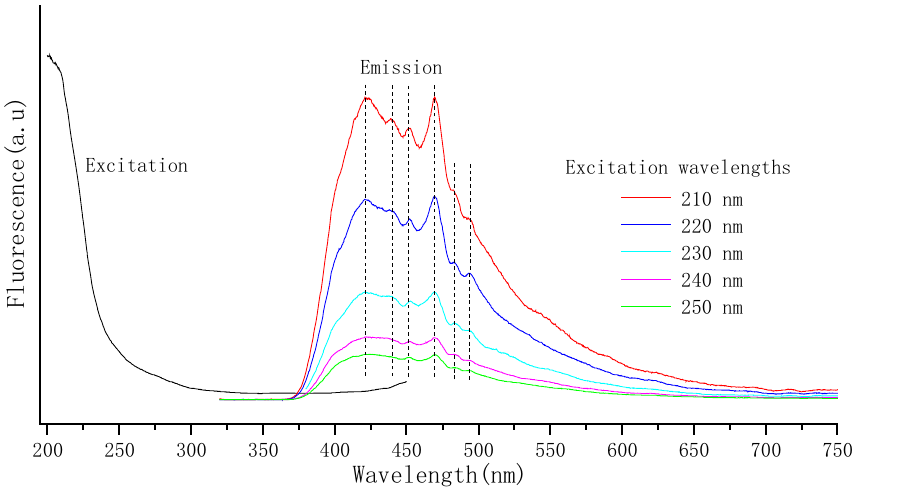
Figure 5. Photoluminescence (PL) excitation and emission spectra of the bacterial PbS